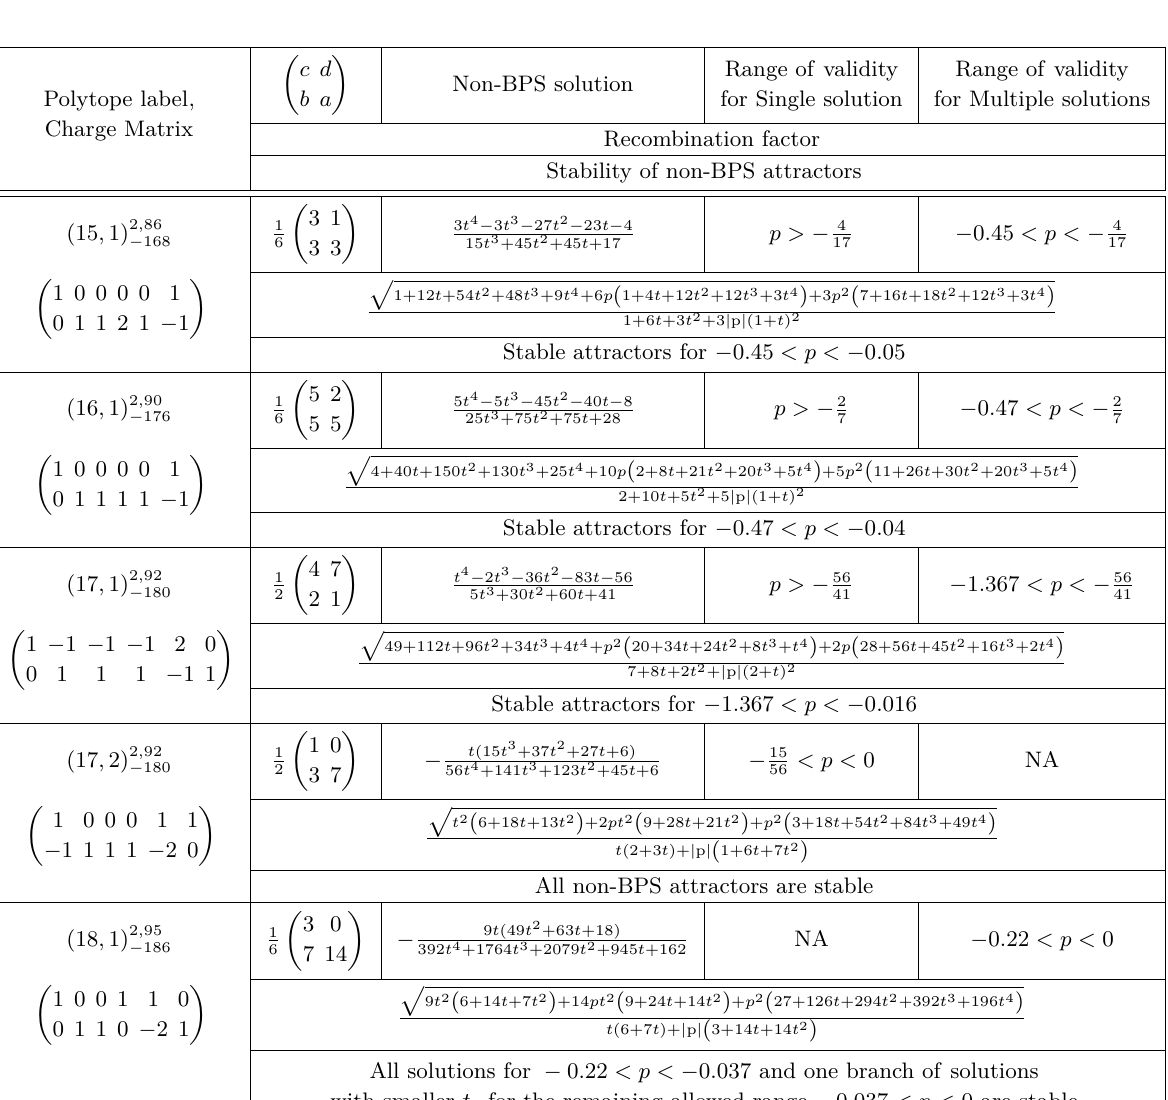
Table 14 . Non-BPS extremal (multiple) black strings in one-modulus THCY models,